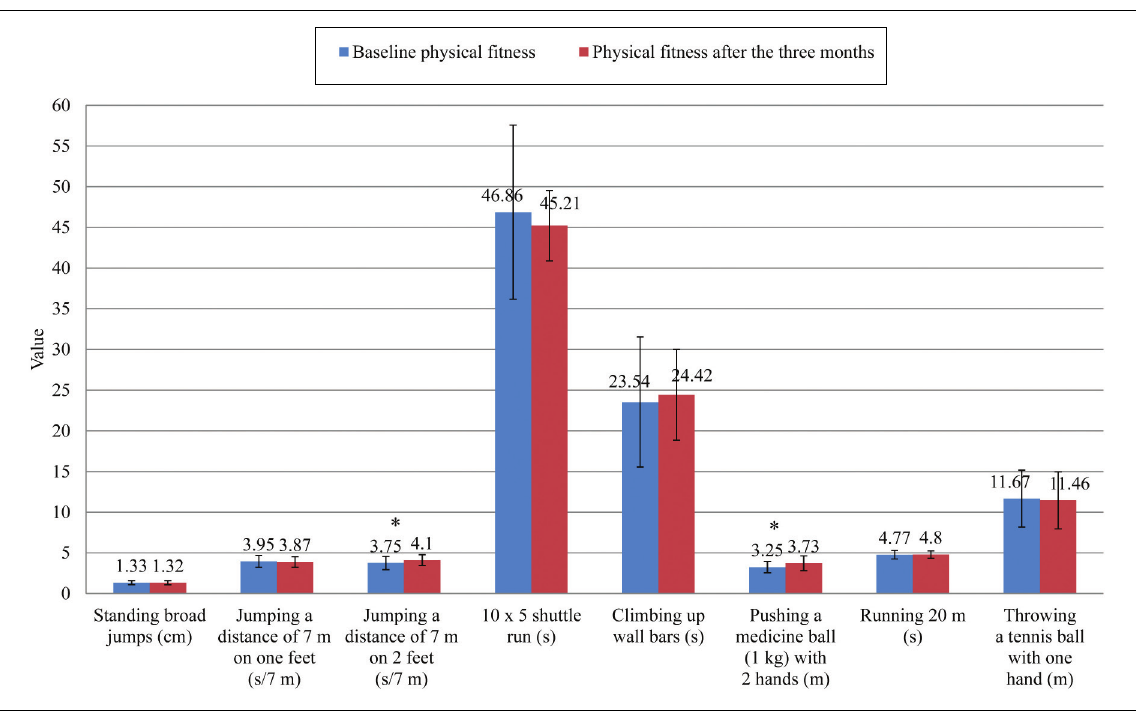
Note. * – p < .05. Figure 3. Changes of physical fitness in three months in the experimental group of girls